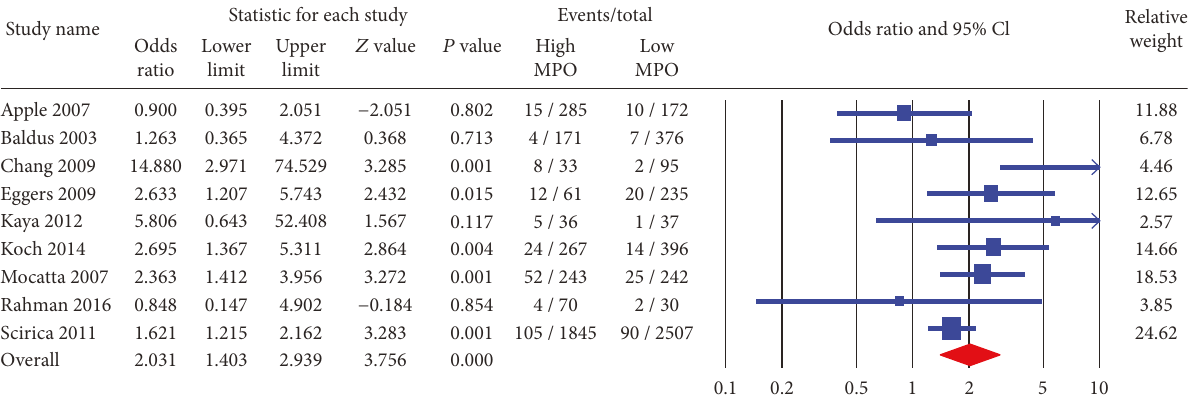
Figure 2: Forest plot for all-cause mortality. High myeloperoxidase level was associated with signi fi cantly higher risk of mortality (odds ratio 2.03; 95% con fi dence interval (CI): 1.403-2.939; P < 0 001